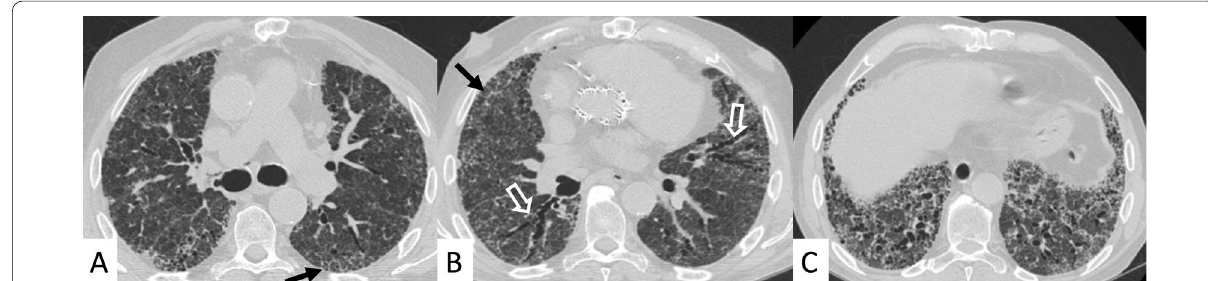
Fig. 30 A 70-year-old man with MCTD, positive for ANCA antibodies. HRCT images show reticulations (black arrows in A, B ) and bronchiectasis, with irregular course through the lung (white empty arrows), and cystic appearance, clearly recognizable in the basal regions in